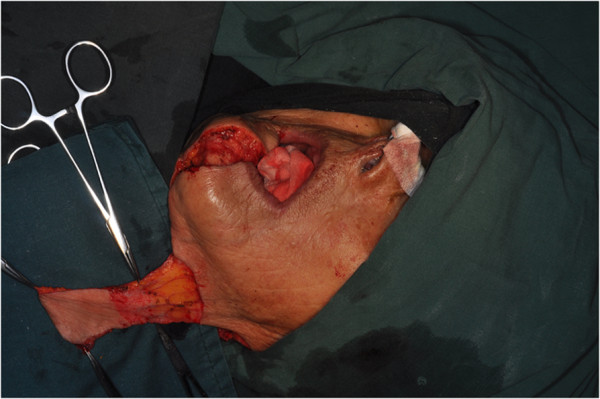
Before reconstructing the defect, the epidermis was removed from part of the flap in the tunnel.